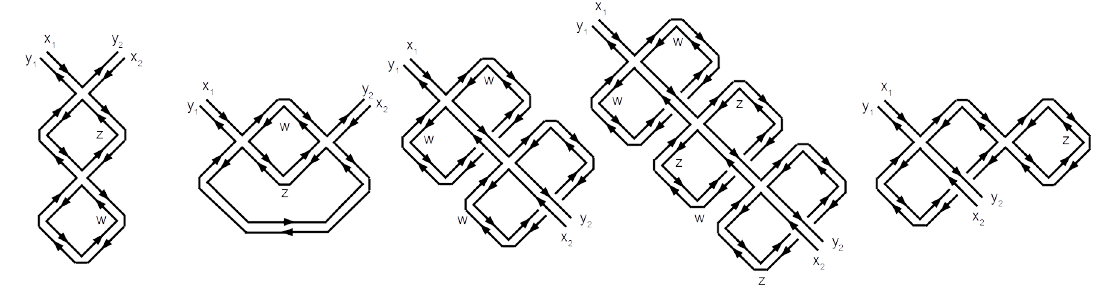
Figure 6 . Several diagrams build using the Feynman rules (4.6), (4.7).